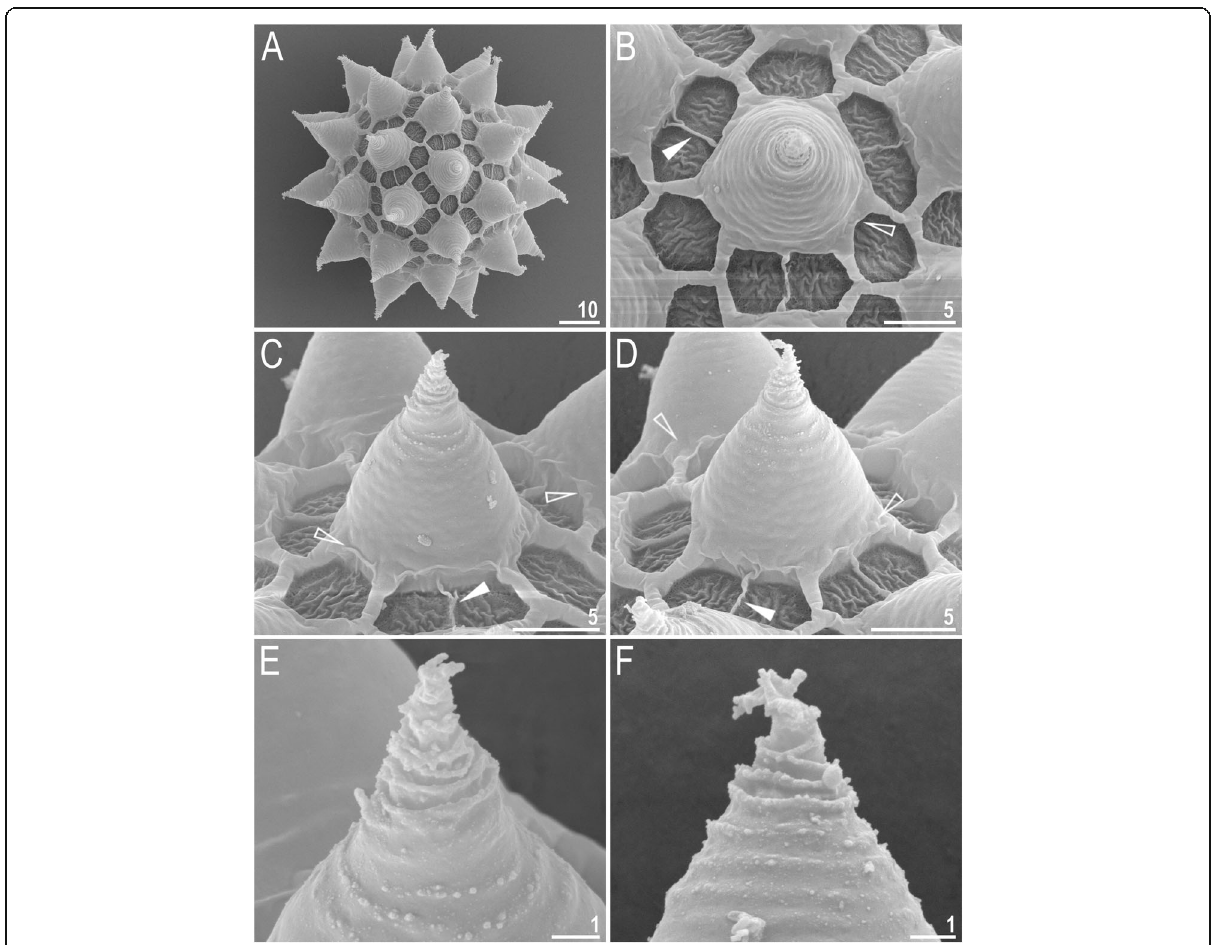
Fig. 19 Macrobiotus pseudopallarii sp. nov. from Montenegro (ME.007) – eggs seen with SEM: a – entire view of the egg; b – f – details of the egg surface between processes, areolation and egg processes. Filled flat arrowheads indicate thickening perpendicular to the process base that divides the areola in the middle, empty flat arrowheads indicate irregular collars around process bases. Scale bars in μ